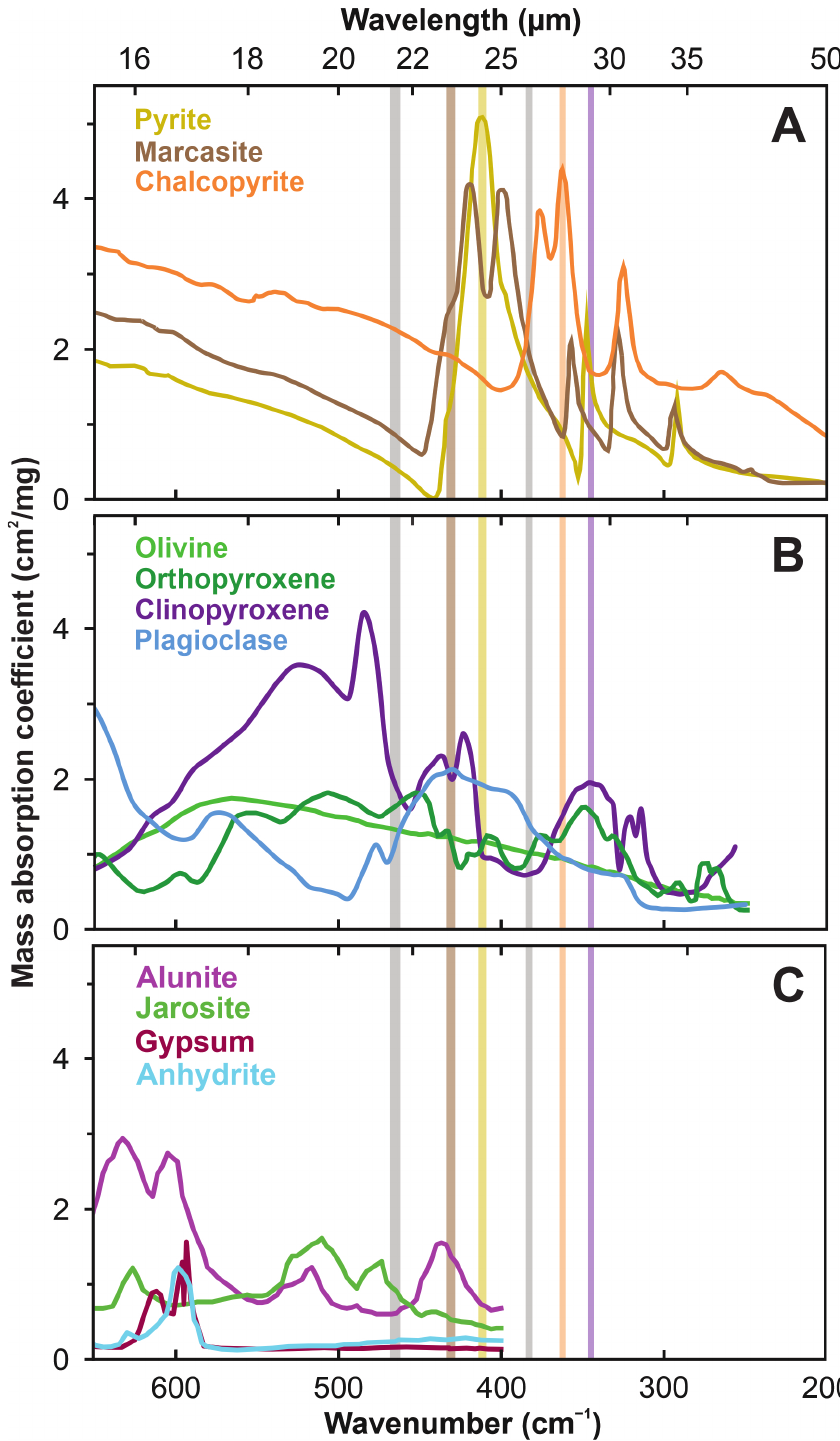
Figure 5. Mass absorption coefficients of possible Martian ( A ) sulfides [23], ( B ) silicates [49–51], and ( C ) sulfates [52–54] measured at room temperature. Literature data for the sulfates and silicates are unavailable for <400 cm − 1 (>25 µ m) and <250 cm − 1 (>40 µ m), respectively. The mass absorption coef- ficients of sulfates were calculated from reported transmittances, sample masses, and KBr pellet cross- sectional areas according to the method presented by Brusentsova et al. [23]. The spectral ranges of the six detectors are marked with rectangles: orange (360–364 cm − 1 = 27.45 − 27.75 µ m: chalcopyrite), yellow (409–414 cm − 1 = 24.15 − 24.45 µ m: pyrite), brown (428–434 cm − 1 = 23.05 − 23.35 µ m: marca- site), gray (381–385 cm − 1 = 25.95 − 26.25 µ m and 462–468 cm − 1 = 21.35 − 21.65 µ m: reference bands), and purple (343–347 cm − 1 = 28.85 − 29.15 µ m: